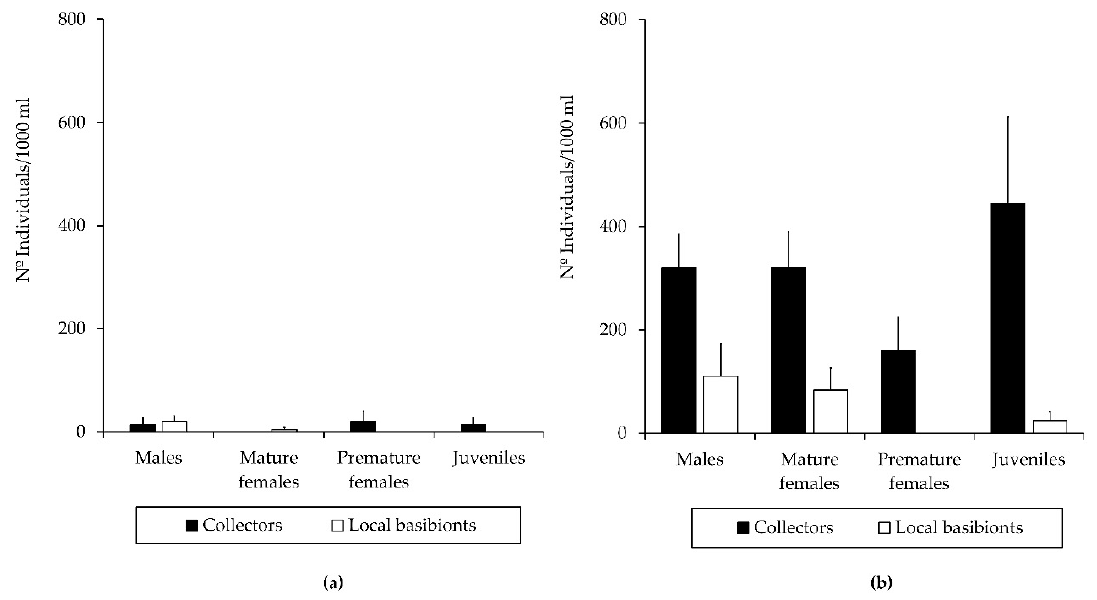
Figure 5. Population structure of Paracaprella pusilla colonizing collectors versus inhabiting local basibionts in Sancti Petri marina in ( a ) the one-month study period ( b ) and the three-months study period.